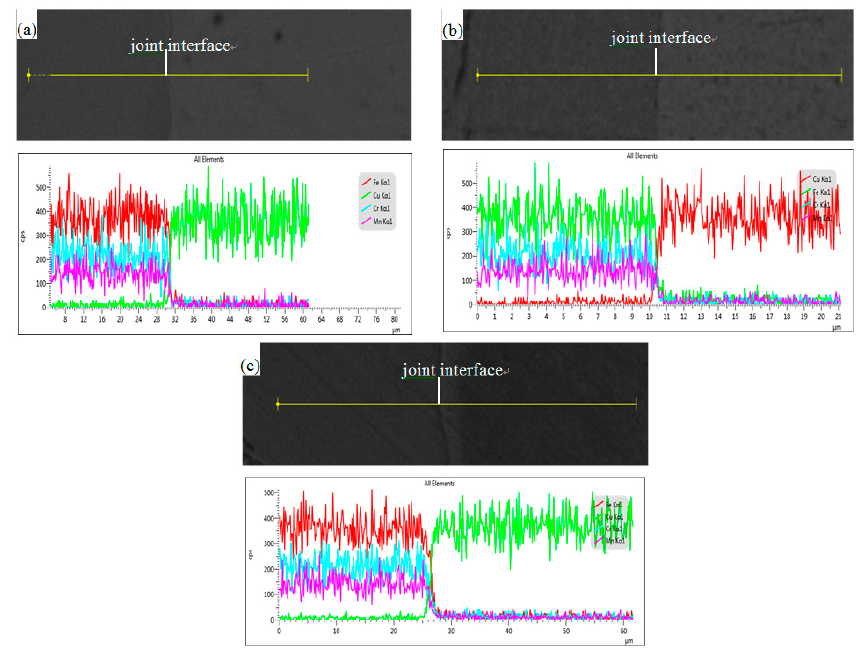
Figure 7. Element line scanning near the joint surface under different explosive welding conditions. ( a ) R =0.9; ( b ) R =1.1; ( c ) R